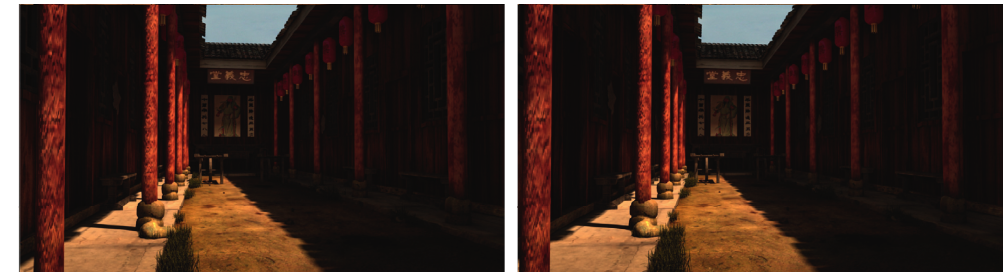
Figure 13: Images of the left and right eyes created by the binocular camera, with the left eye sequence static needle image on the left and the right eye sequence static needle image on the